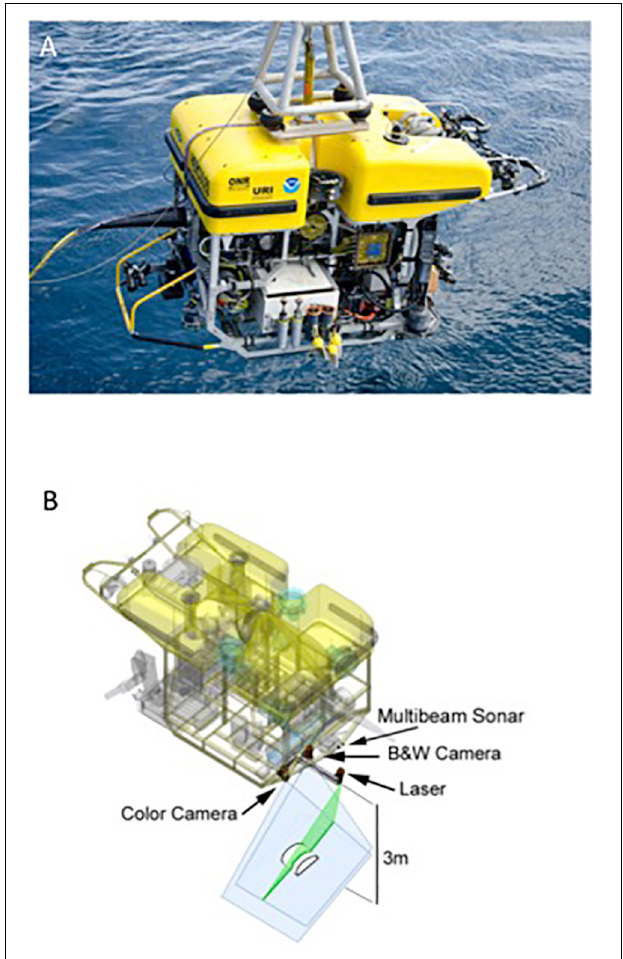
FIGURE 2 | ROV Hercules (A) during deployment. The imaging suite is mounted on the aft of the vehicle. (B) CAD drawing showing the high resolution imaging system and sensor